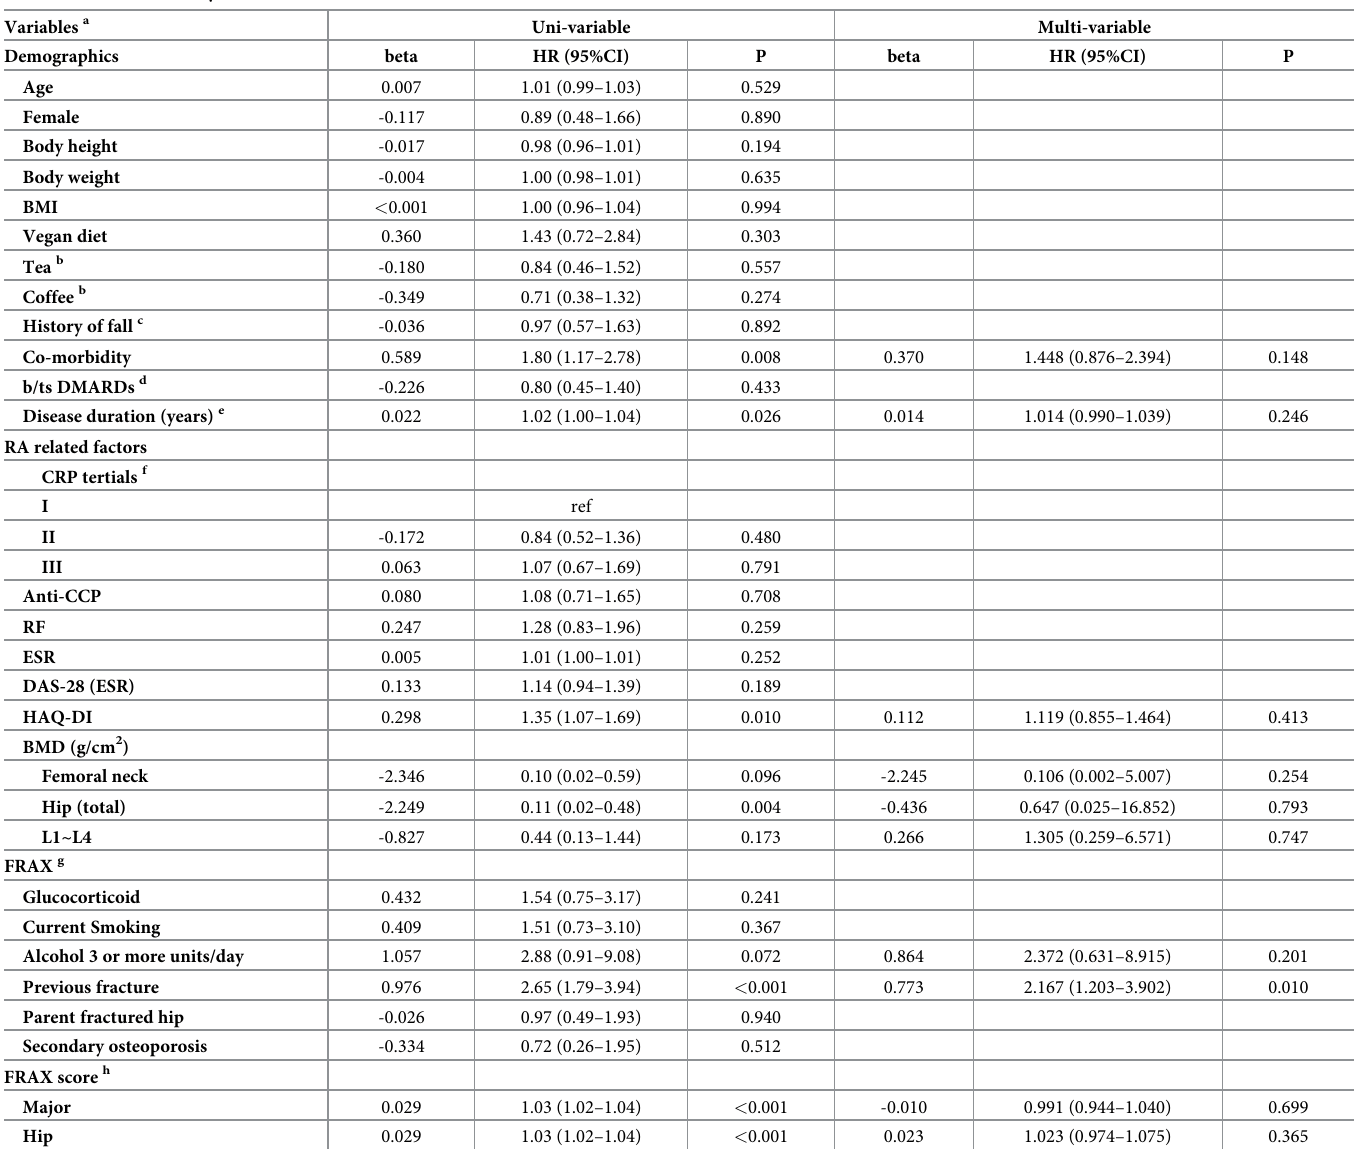
Table 4. Risk factor analysis of new incident fracture after